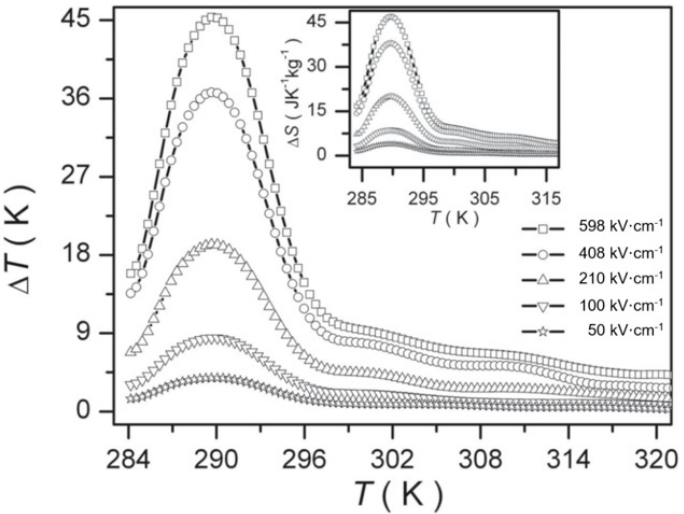
Figure 25. Δ T of PBZ film at selected electric fields, the inset is Δ S . Reprinted with permission from [105]. Copyright 2013 WILEY-VCH Verlag GmbH & Co.